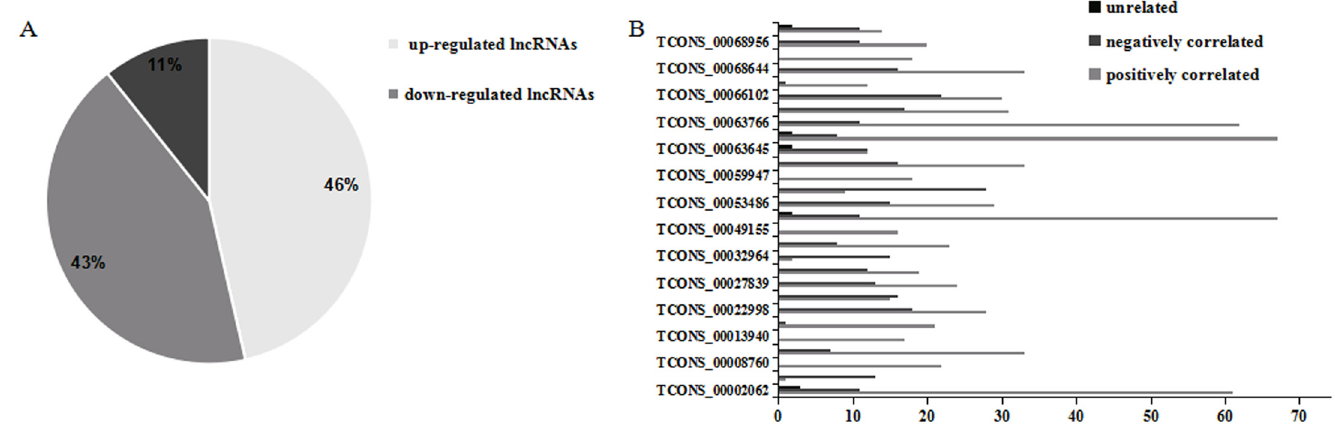
Fig 4. The expression of 28 lncRNAs and target genes. (A) The expression of 28 LncRNA which have significant changes. (B) The relationship between significantly expressed lncRNAs and their target genes during rat liver regeneration.